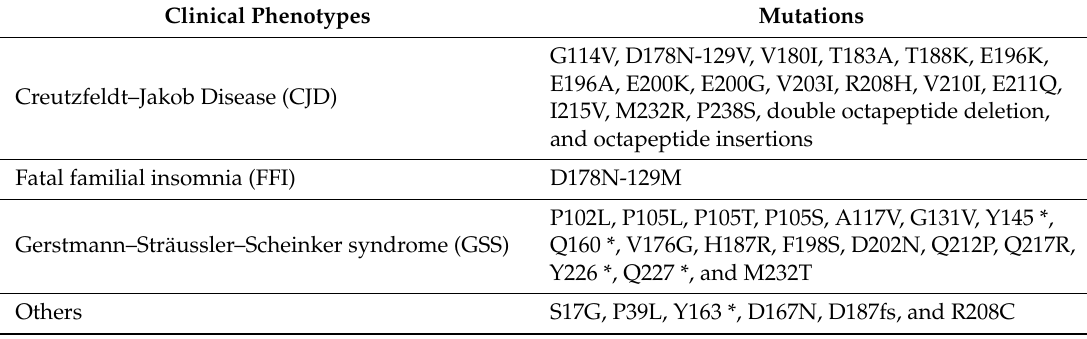
Table 1. Classification of pathogenic mutations of prion disease according to clinical phenotypes in previous